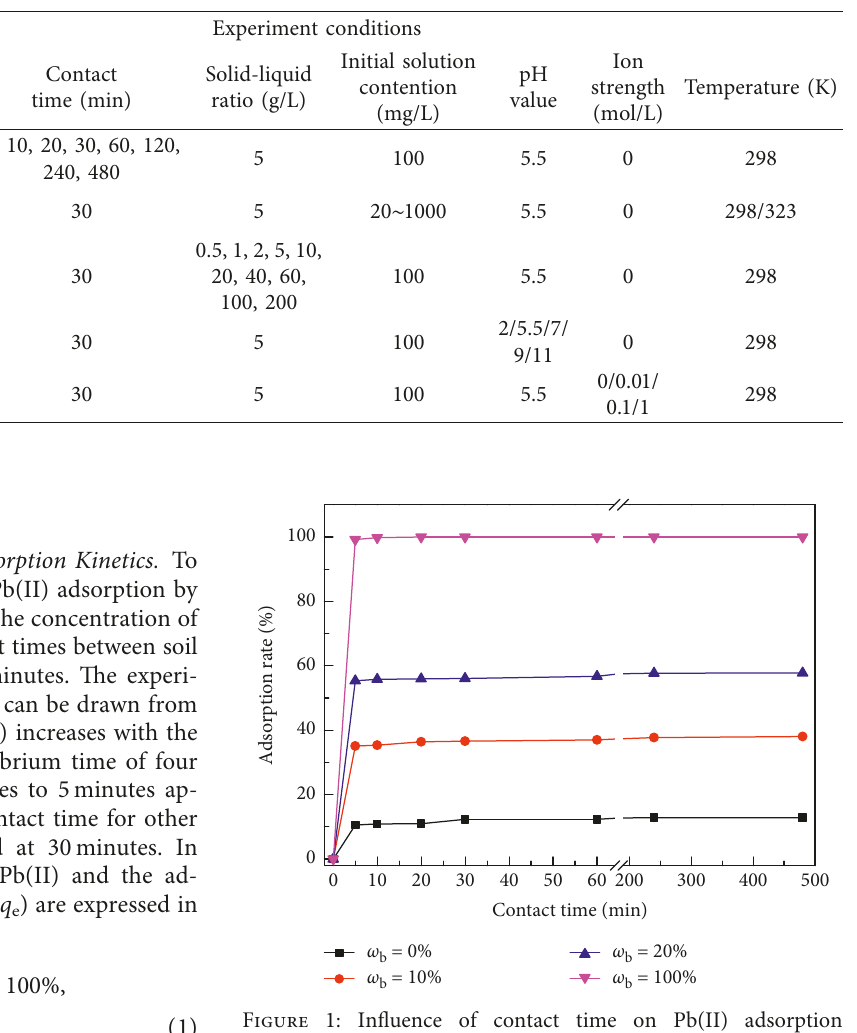
Table 3: Experiment conditions of Pb(II) adsorption property of soil.